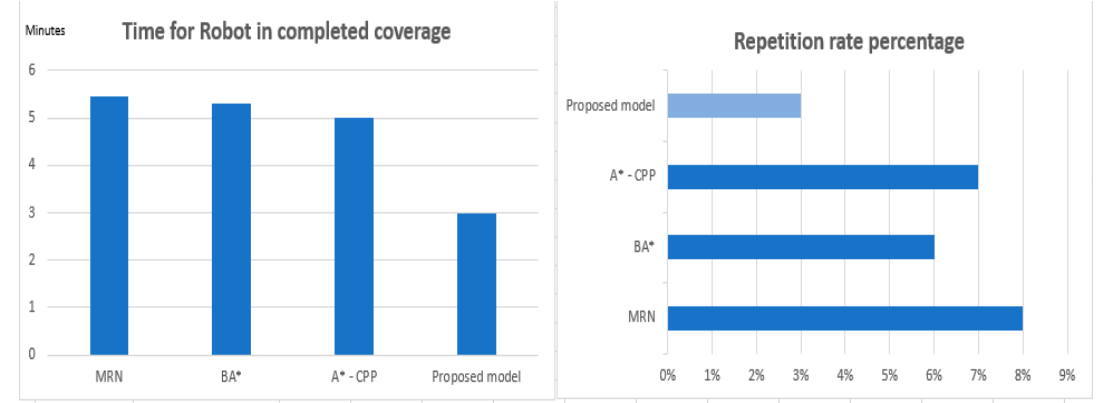
Figure 10. The duration times and repetition rate for robot visits in dynamic environments.